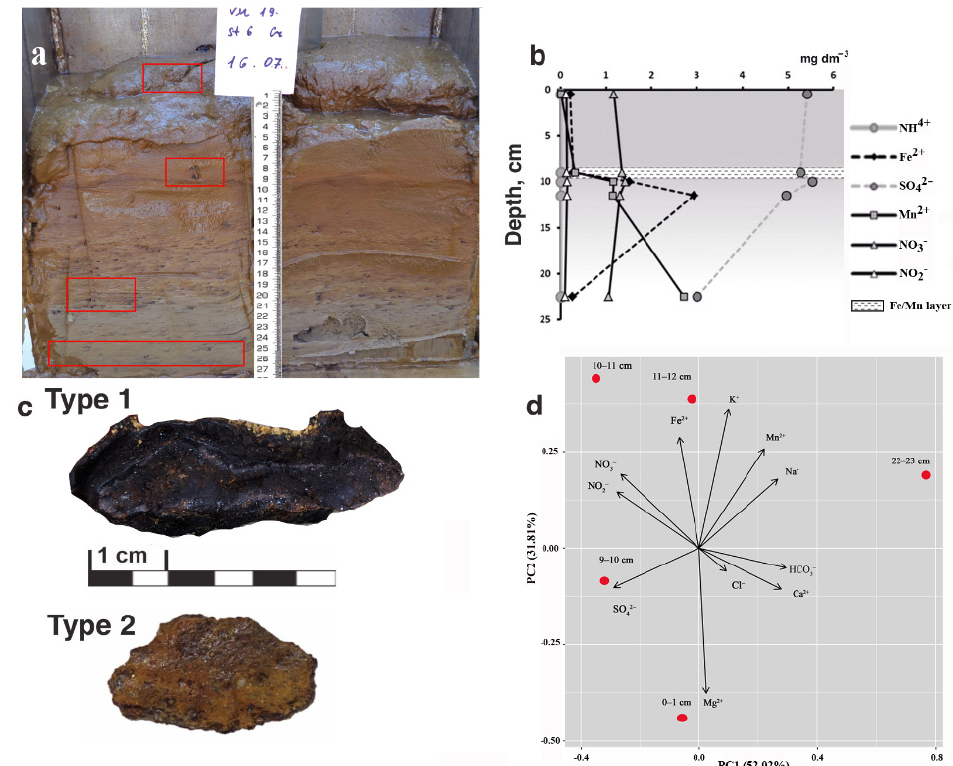
Figure 2. ( a ) Sediment section of grab St6 Grf7; red rectangles indicate Fe-Mn nodule locations throughout the sediment section; ( b ) Pore water concentration profiles; ( c ) Two morphological types of nodules: black, with a two-layered structure (Type 1) and reddish (Type 2); ( d ) Scatter plot of points in the space of two principal components based on the chemical composition of the pore water in different sedimentary layers. The arrows indicate the vectors directed along the gradients of changes in the parameters studied in the samples.